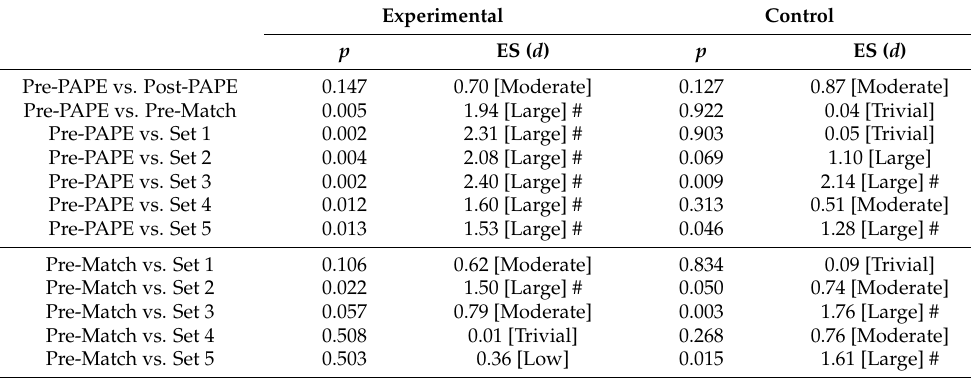
Table 3. Effect size of intragroup differences in CMJ for Pre-PAPE and Pre-Match vs. the rest of the tests for control and experimental